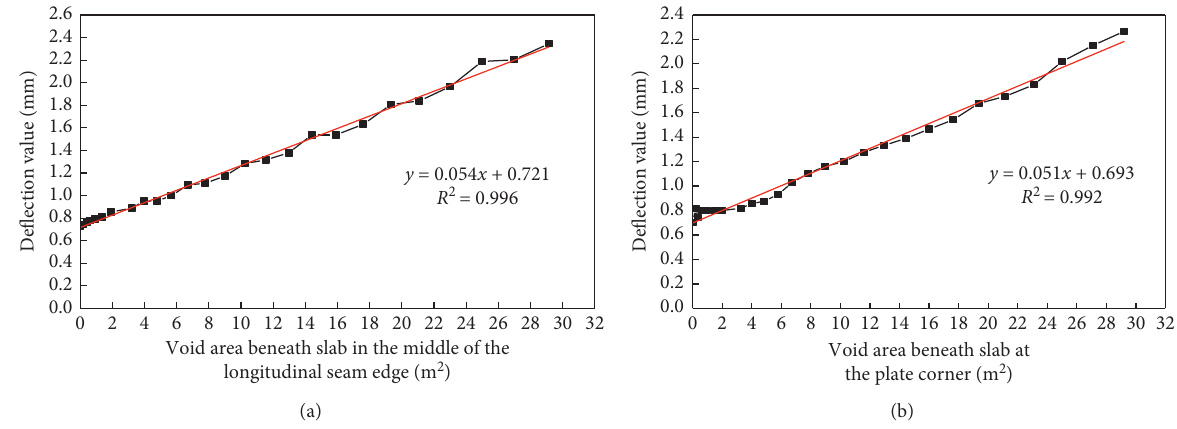
Figure 17: Relationship between the deflection and void area beneath slab. (a) The middle of longitudinal seam edge. (b) The slab